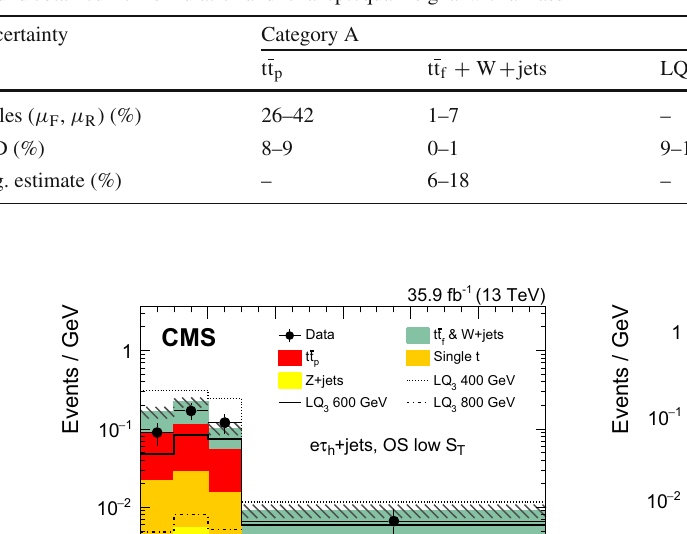
tom panel, the ratio of data to SM background is shown together with statistical (dark gray) and total (light gray) uncertainties of the total SM